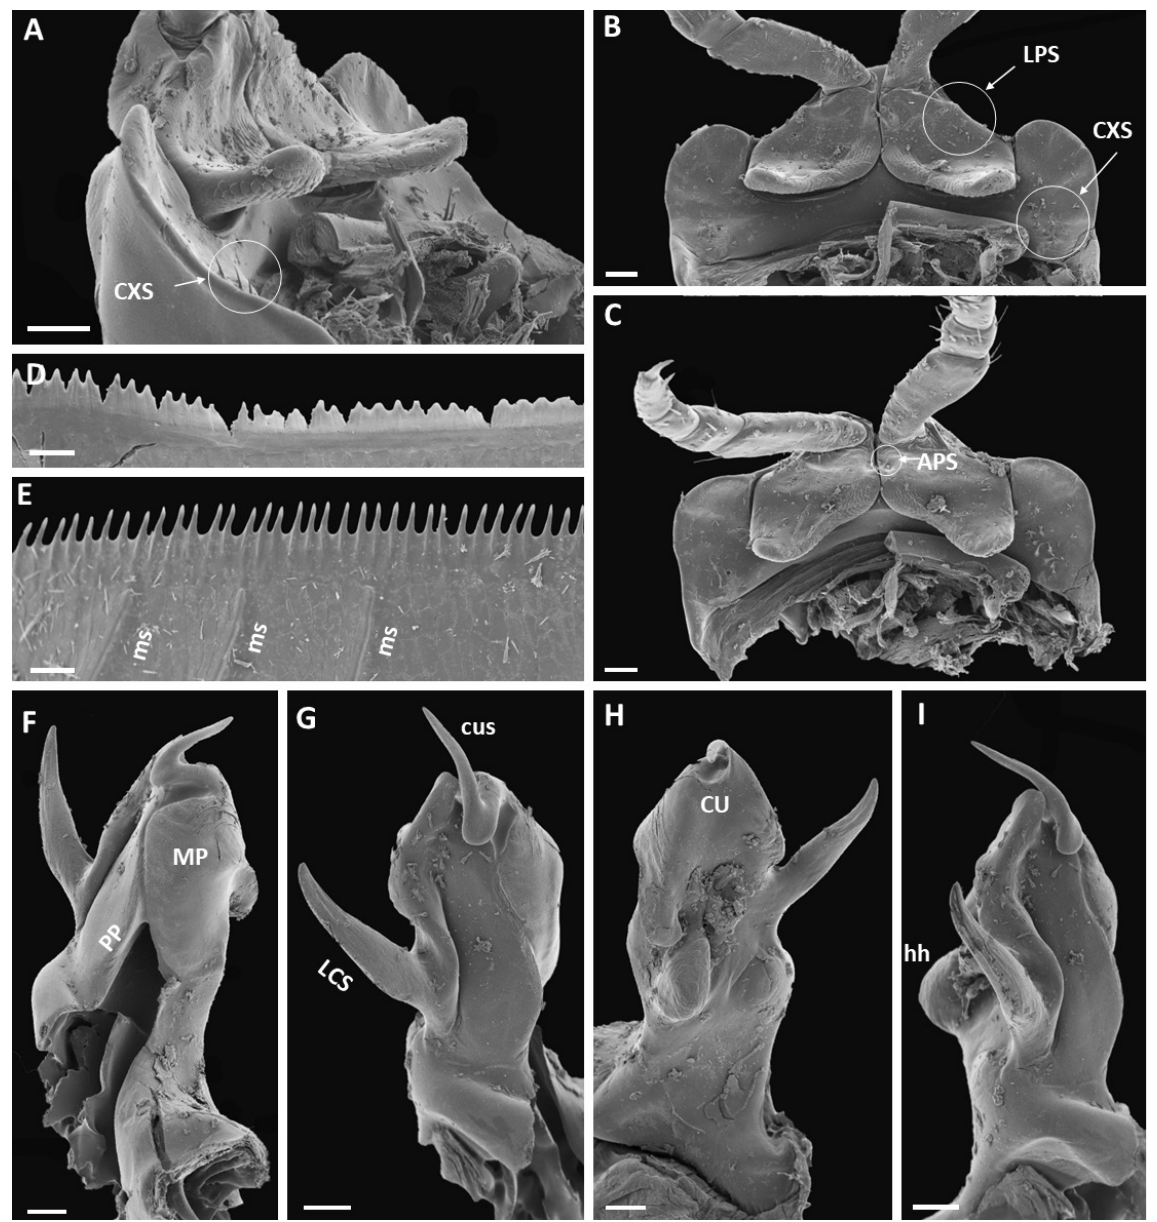
Fig. 19. Calyptomastix xystopygoides sp. nov., holotype, ♂ (NHMD 621718). A–C . First pair of legs. A. Sublateral view. B. Anterior view. C. Ventral view. D . Midbody dorsal limbus (worn). E . Midbody ventrolateral limbus. F–I . Left gonopod coxa. F. Anterior view. G. Anterior-lateral view. H. Posterior- mesal view. I. lateral view. Abbreviations: APS = mesapical prefemoral setae; CU = cucullus; cus = cucullar spine; CXS = coxosternal setae; hh = hemisphaerical hump; LCS= lateral coxal spine; LPS = lateral prefemoral setae; MP = metaplica; ms = metazonital striae; PP = proplica, Scale bars: A–C, F–I = 0.1 mm; D–E = 0.02